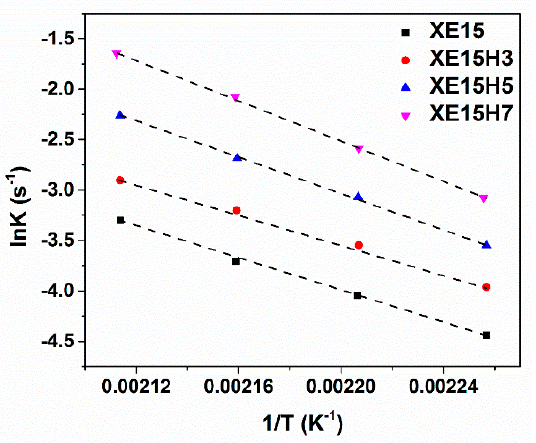
Figure 6. Plots of ln(K) with respect to 1/T for various prepared nanocomposites.